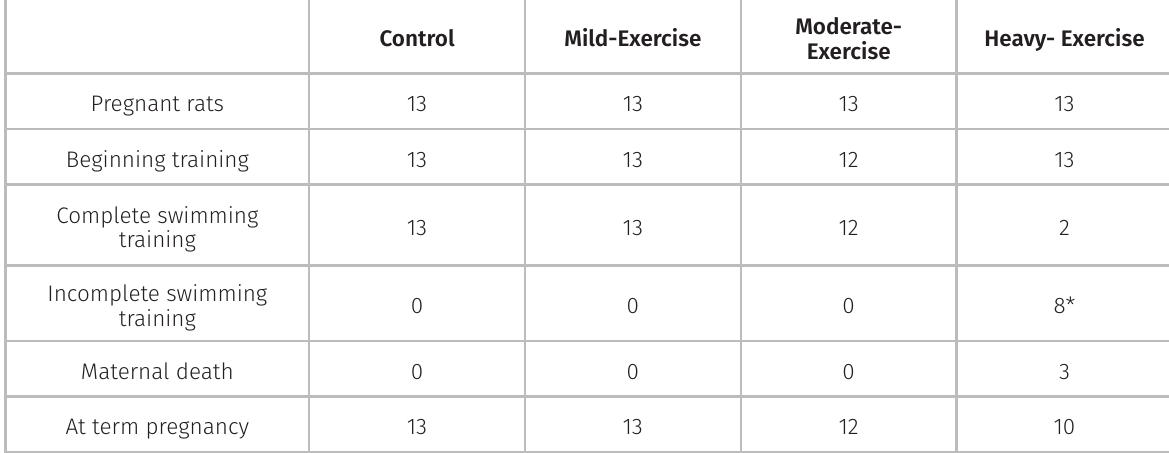
Table I. Outcomes of female rats submitted to mild, moderate and heavy-exercise intensity during